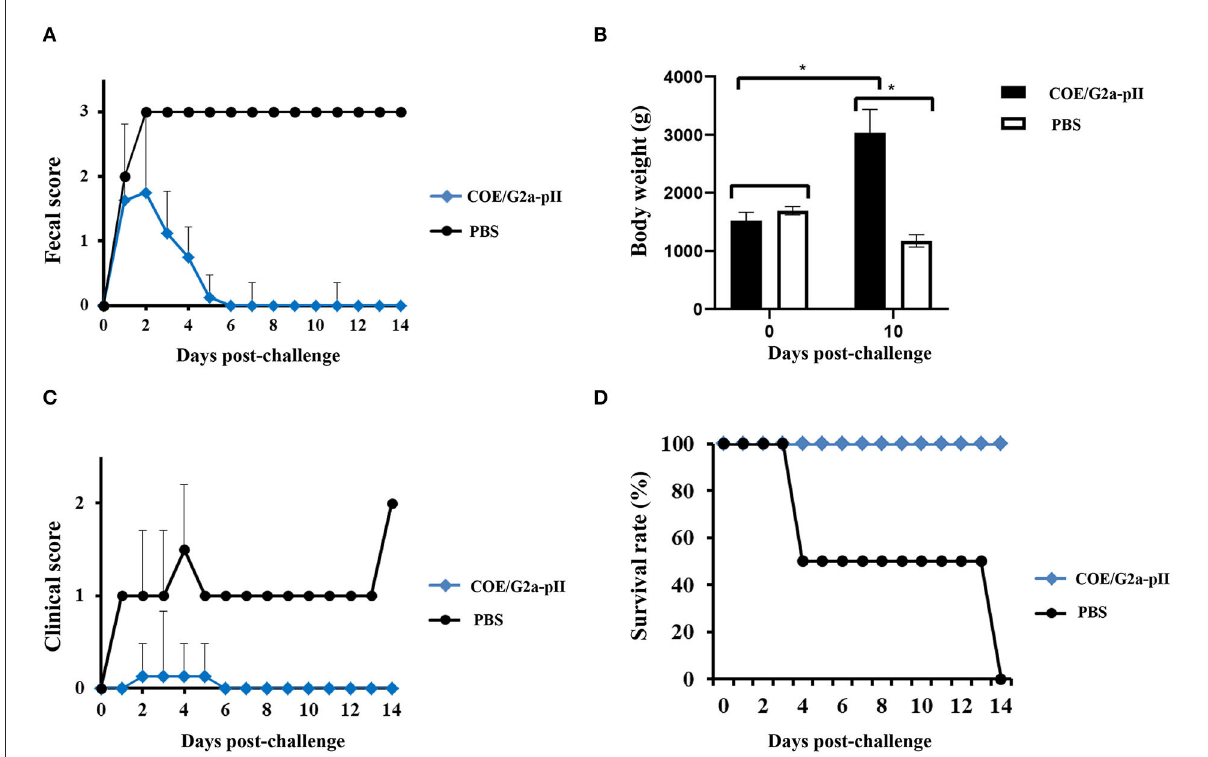
FIGURE4 Clinical observation and the survival of piglets obtained passive immunity from sow vaccination. The value is presented as the mean ± standard deviation (SD). * means a statistically significant difference ( p < 0.05). (A) Fecal score of piglets ( n = 8 for COE/G2a-pII group and n = 2 for PBS group) was recorded daily after challenge with highly virulent NAVET/PEDV/PS6/2010 strain. (B) The body weight of piglets was calculated on the days 0 and 14pc. (C) The clinical scores of piglets were analyzed daily after the challenge. (D) After the challenge, the survival rate of piglets was recorded